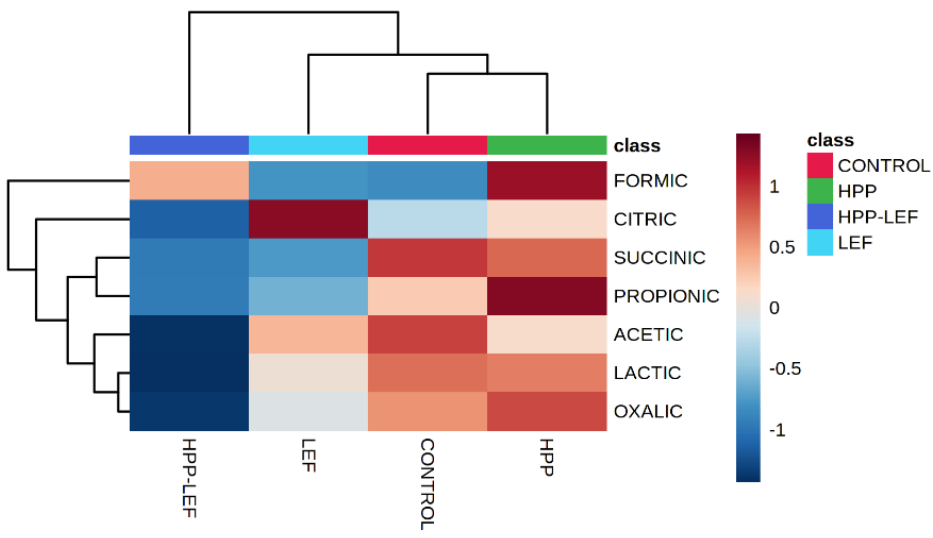
Figure 5. Hierarchical clustering results shown as a heatmap of organic acids associated with the different treatments (control, HPP, LEF and HPP-LEF) of the cheese samples during storage at 4 °C. Ward-linkage clustering was based on the Euclidean correlation coefficients of the identified organic acids in the different cheese samples. The color scale represents the scaled abundance of each variable, with red indicating high abundance and blue indicating low abundance.